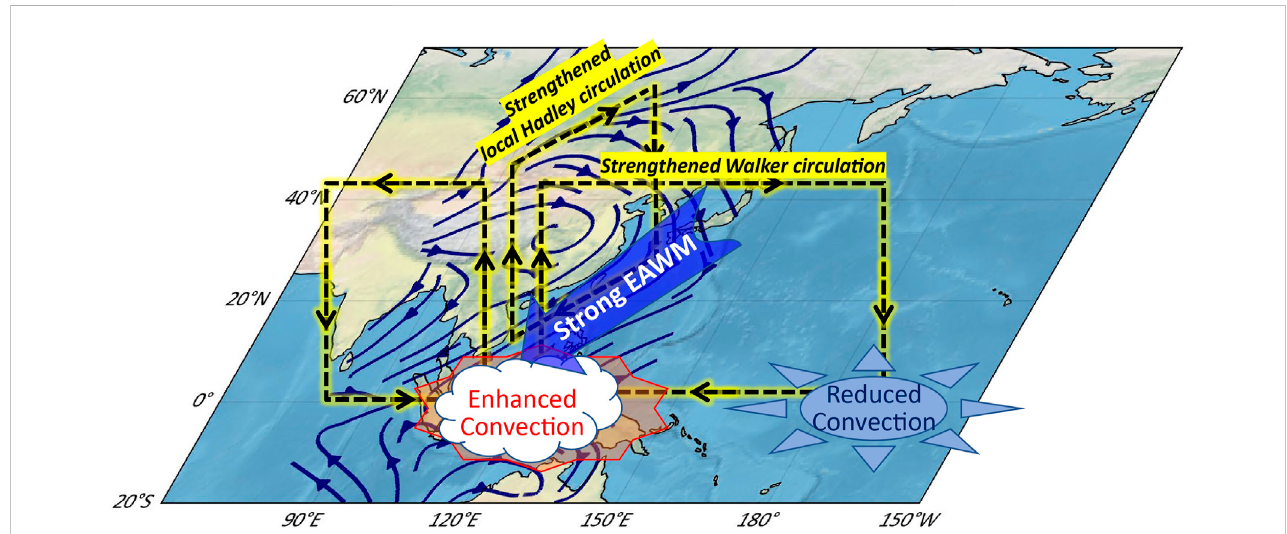
Schematic diagram illustrating the effects of EAWM on tropical convection and large-scale atmospheric circulation. A strong EAWM can cause anomalous convergence over the tropical western Paci fi c region, leading to enhanced convective activities there. The enhanced convection further leads to strengthened local Hadley circulation over East Asia and strengthened Walker circulation along the equatorial